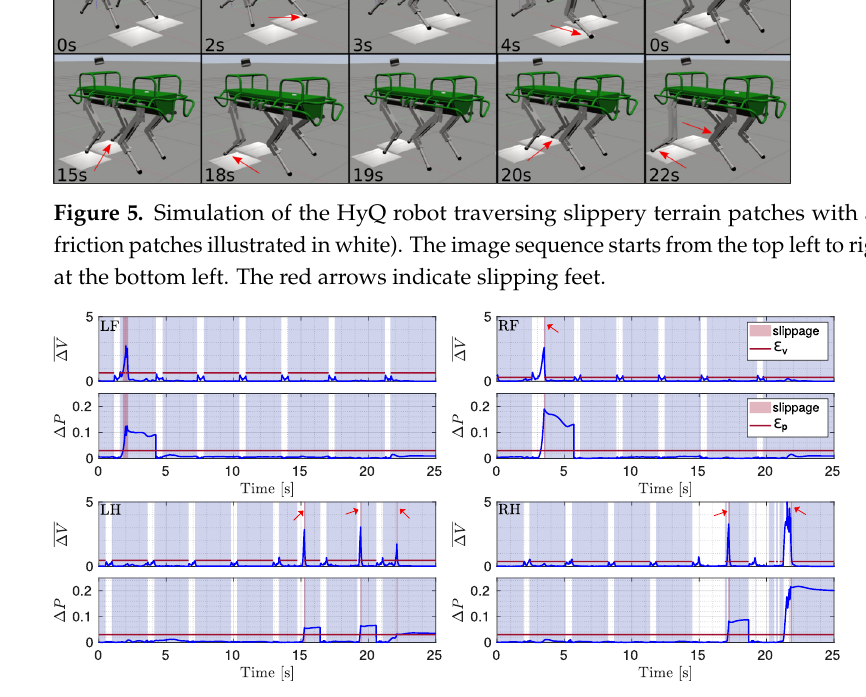
Figure 6. Plots of ∆ V and ∆ P (blue) with respective thresholds (red line) illustrated for the four legs (LF, RF, LH, RH) during a crawl gait. The gray shaded area shows stance phases and the red shaded area marks slippage. The little red arrows indicate short slip events.